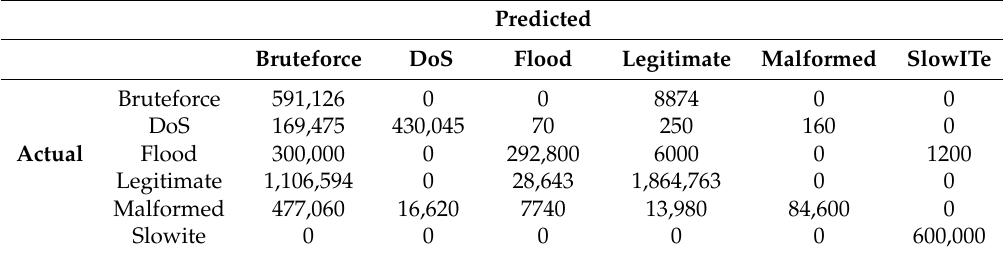
Table 15. Confusion matrix naïve bayes with augmented and balanced